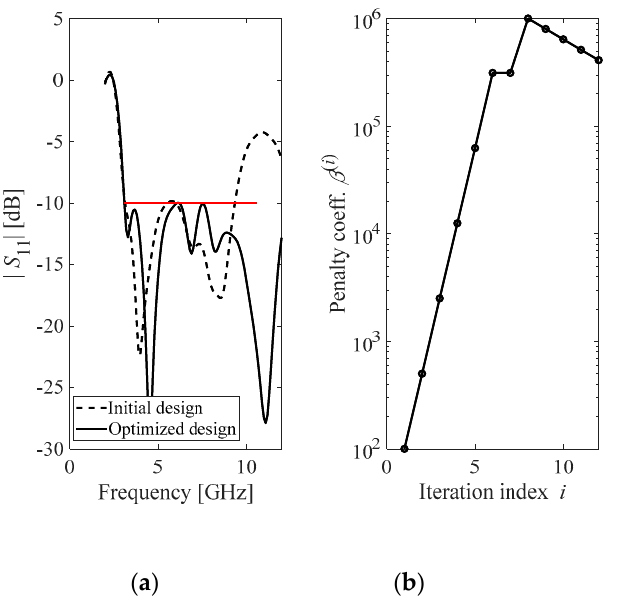
Figure 7. Antenna II: representative run of the proposed algorithm with automated adjustment of the penalty factors: ( a ) reflection coefficient at the initial (- - -) and optimized design ( — ); ( b ) evolution of the penalty coefficient throughout the algorithm iterations.